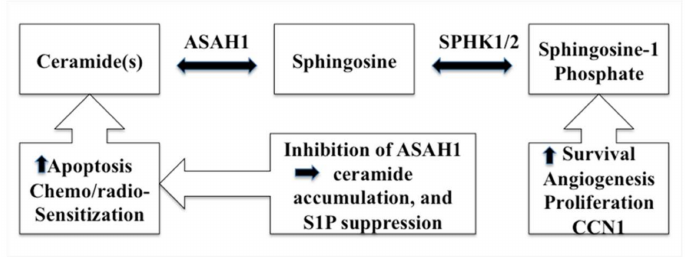
Figure 2. A schematic diagram describes the ceramide metabolism pathway and the resulting effects of inhibiting ASAH1.